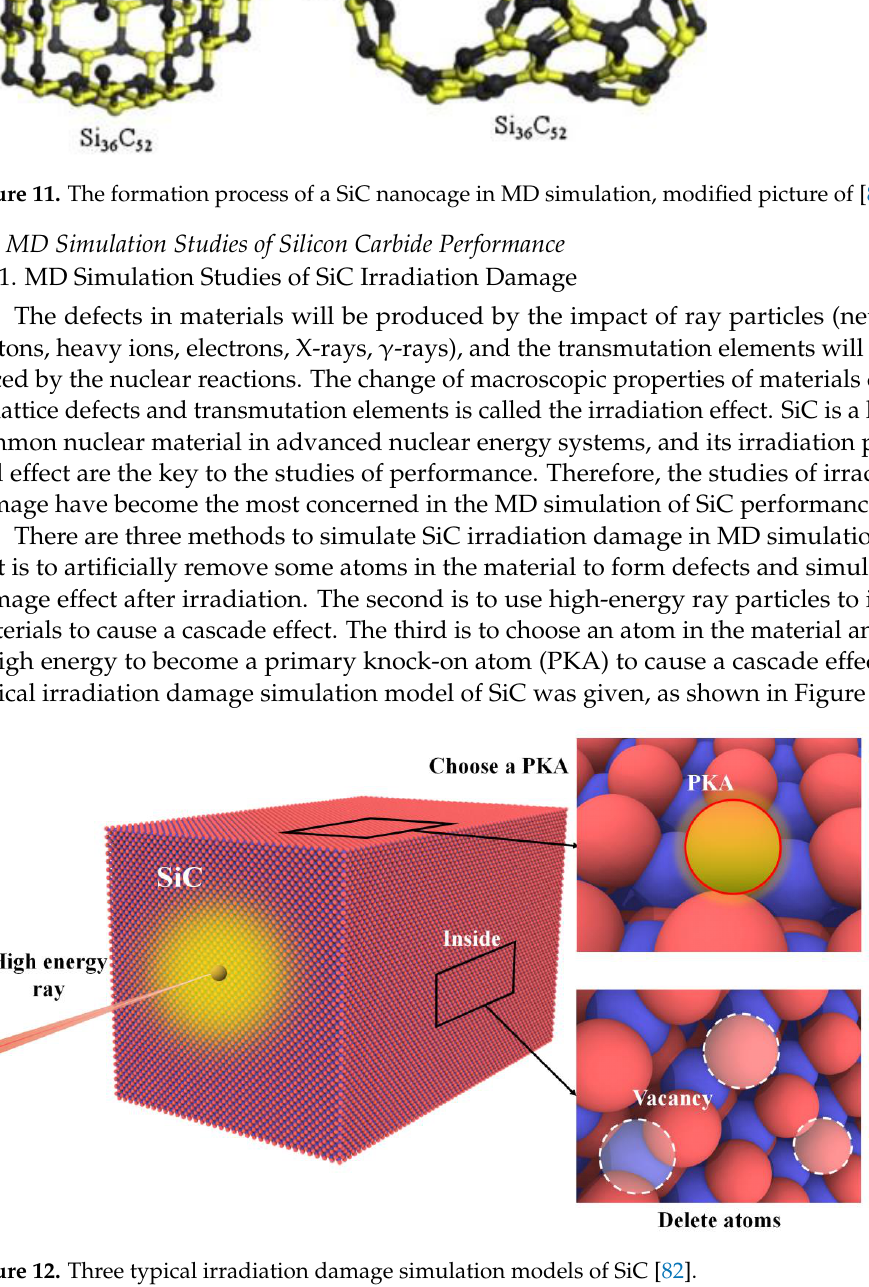
Figure 13. The typical irradiation damage mechanism simulation model of SiC, modified picture of [28]. To sum up, there are two aspects in MD simulation studies of the effects of irradiation on SiC properties. The first is the effects of irradiation on the thermal properties of SiC (mainly the thermal conductivity). Wang et al. [28] studied the effects of irradiation on the thermal conductivity of 3C-SiC by simulating the irradiation effect with high-energy Si atoms and subsequent cascade collisions. Nguyen et al. [83] studied the relationship be- tween defect thermal conductivity and vacancy concentration and irradiation dose by cal- culating the thermal conductivity of SiC/SiC composites under neutron irradiation. Sa- molyuk et al. [31] studied the effects of irradiation-induced single vacancy and small va- cancy clusters/micropores on the thermal conductivity of 3C-SiC. Dong et al. [29] studied the effects of the irradiation-induced point defects at the interface of SiC/SiC composites